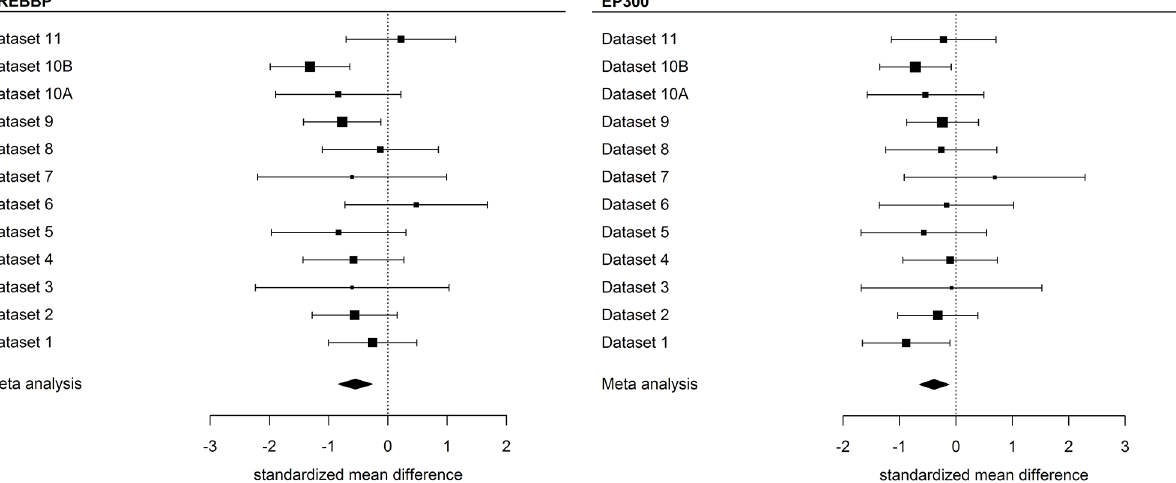
Fig 4. CREBBP/EP300 expression in individual studies. Forest plots for CREBBP and EP300. Squares are proportional to weights used in the meta- analysis, and the lines represent the 95% confidence interval. The diamond represents the standardized mean difference (log2 scale).